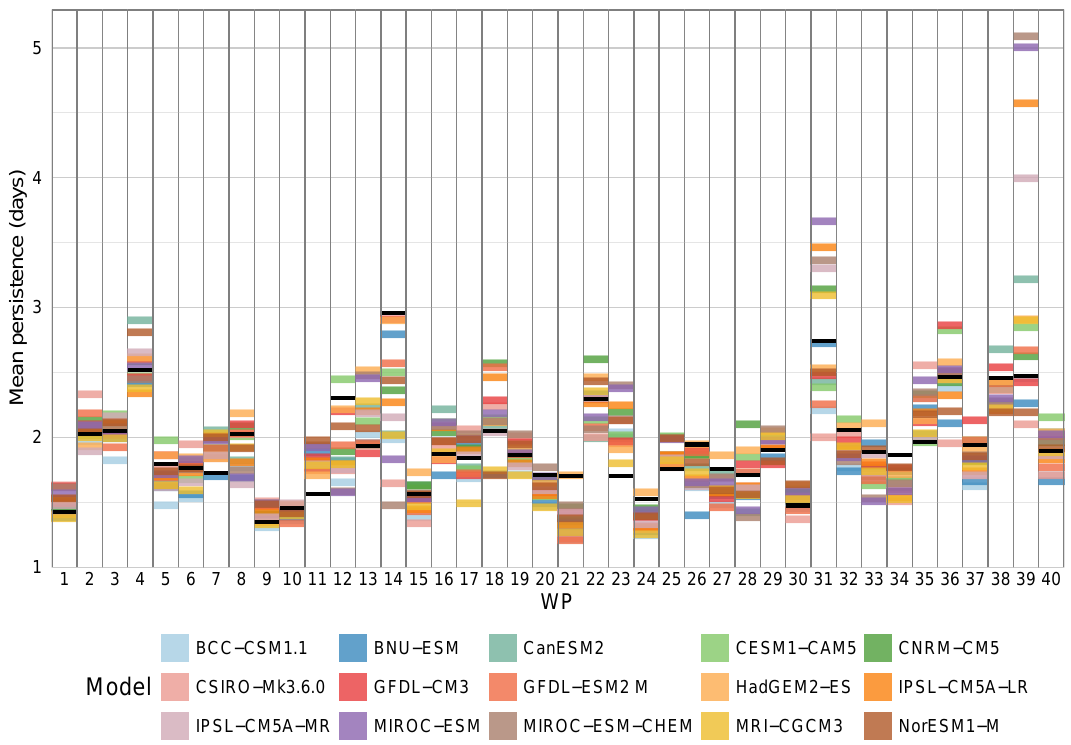
Figure 10. Persistence of patterns (mean number of consecutive days with the same pattern) in GCMs (coloured dashes) compared to persistence on reanalysis data (black